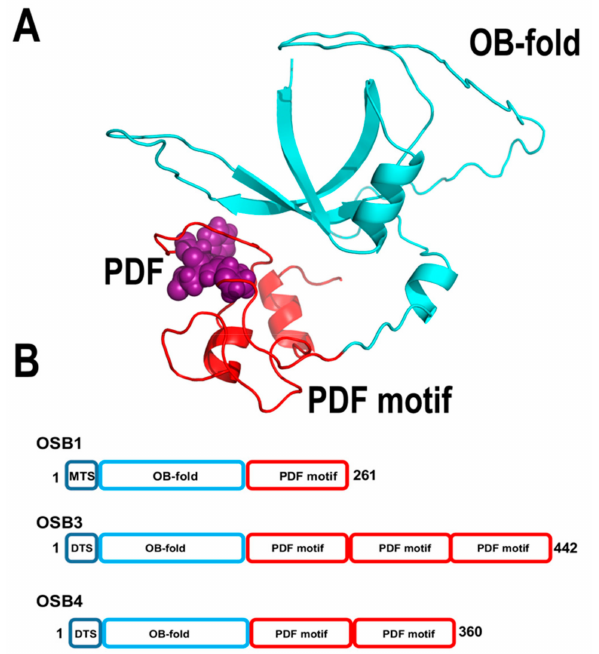
Figure 11. Structural organization of OSBs. ( A ) Structural model of AtOSB1 showing its predicted OB-fold and PDF motif domains. ( B ) Modular organization of mitochondrial OSBs in Arabidopsis . AtOSBs consist of an OB-like fold followed by one to three PDF motifs (54). Although AtOSB1 is depicted as a monomer, AtOSB2 in solution assembles as